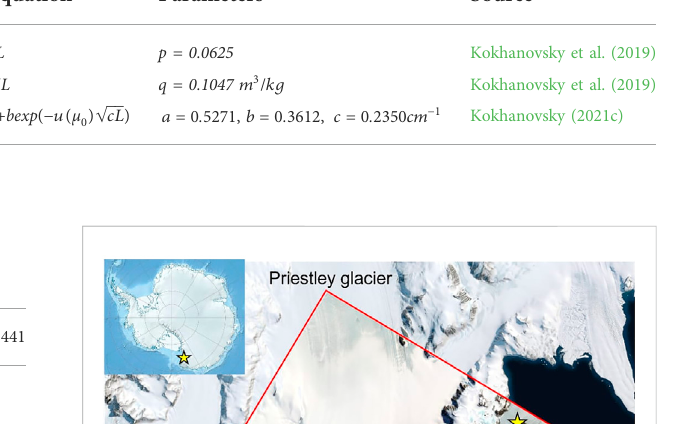
parameter for various snowpacks measured by Libois et al. (2014), k ( λ 0 ) is the volumetric absorption coef fi cient of impurities at the wavelength λ 0 de fi ned as the ratio of average absorption cross section of particles to their average volume (Kokhanovsky, 2021c). The external mixture of ice grains and